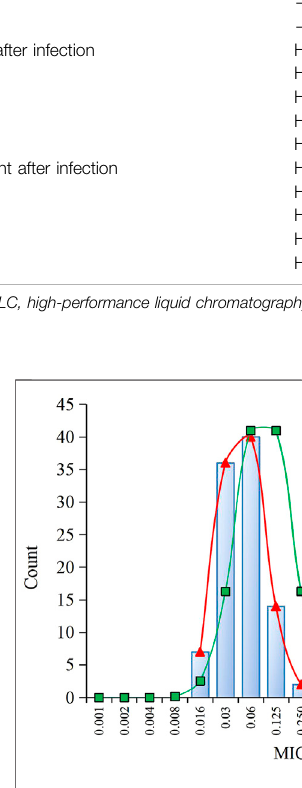
FIGURE 1 | The minimum inhibitory concentration (MIC) distribution of avilamycin against 120 strains of Clostridium perfringens and nonlinear